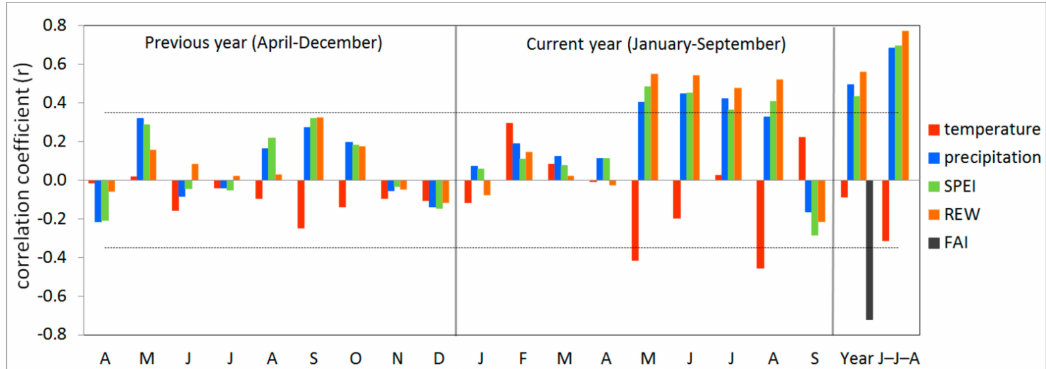
Figure 7. Correlations between climate indices and the mean standard ring-width chronology of all sites. Dotted lines denote the 95% significance level (SPEI: standardized precipitation evapotranspiration index, REW: relative extractable water, FAI: forestry aridity index, Year: January–December of the current year, J–J–A: June–July–August).